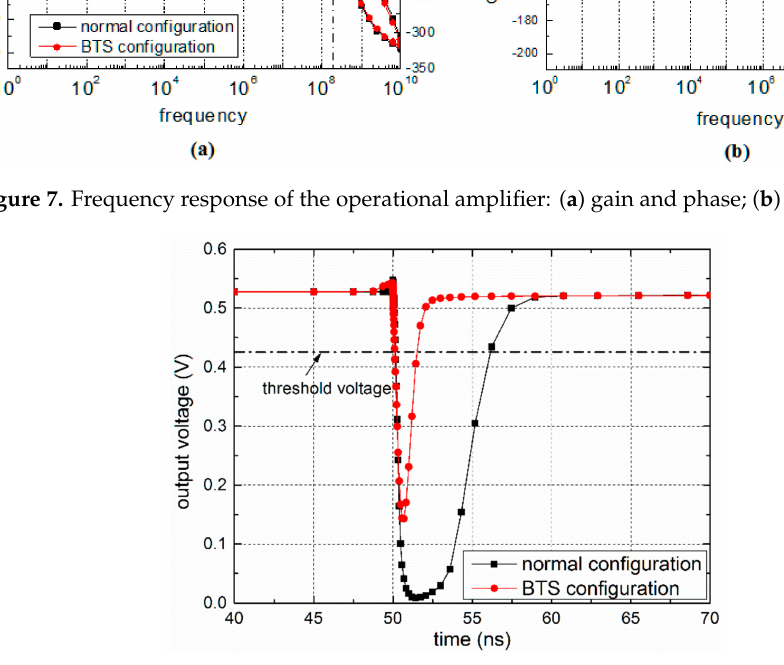
Figure 8. SET induced voltage follower disturbance with di ff erent N-well bias configurations.